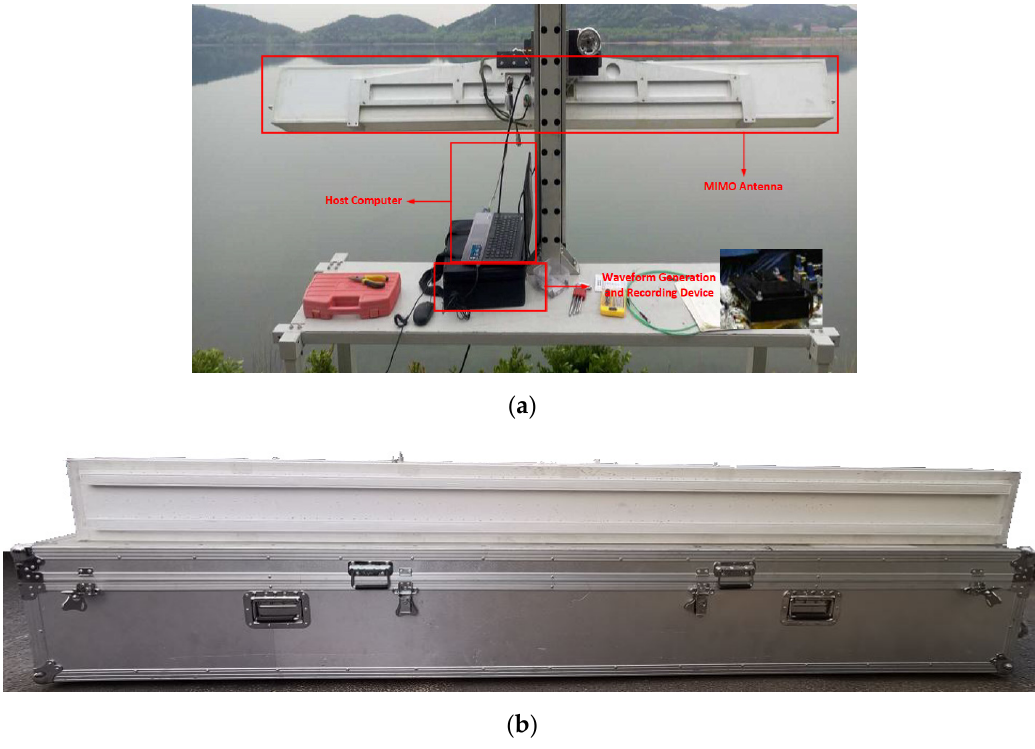
Figure 4. Ground-based multi-input multi-output synthetic aperture radar (MIMO SAR). ( a ) The structure of the radar; ( b ) the MIMO antenna.